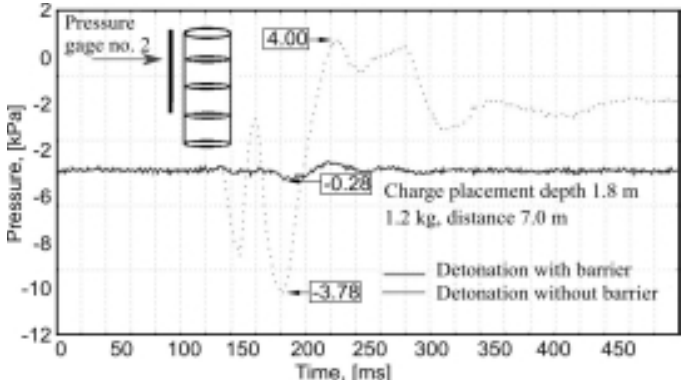
Fig. 14. Time histories of pressures p h on the structure front, measured by gage No. 2 from a detonation at 7.0 m from the silo.